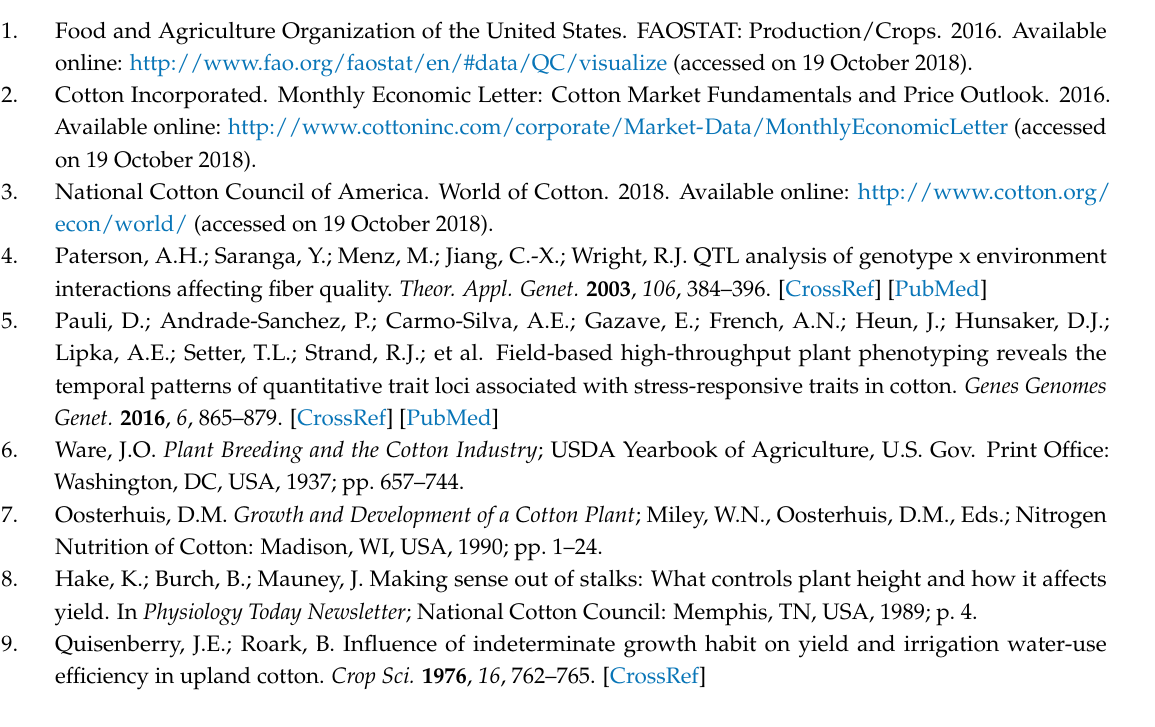
Figure S1: Growth curves 2016, Figure S2: Growth curves 2017, Table S1: Plant height means and standard deviations, Table S2: Repeatability and standard